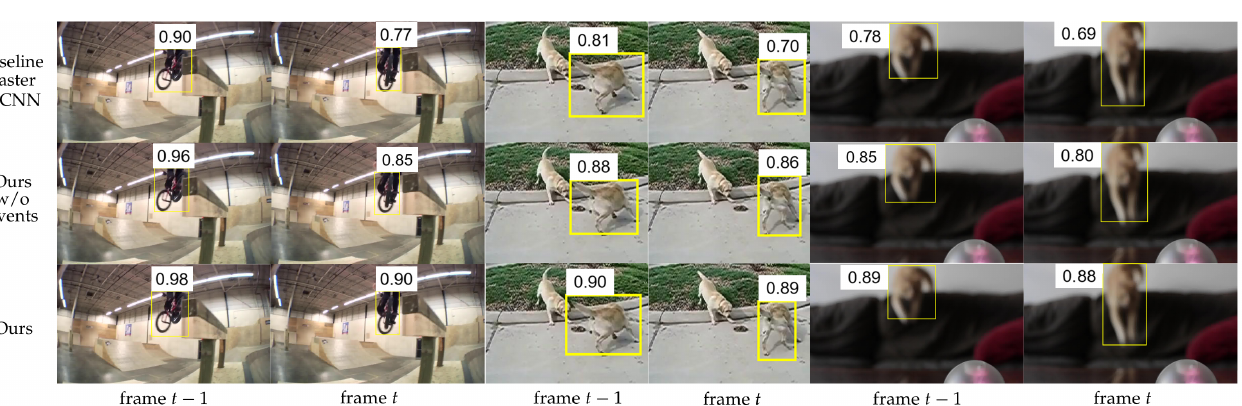
Figure 7. Detection results of “aspect ratio change” events from ImageNet VID validation dataset. Our proposed method using the event detection module shows improvements of detecting “aspect ratio change” events compared with the still-image baseline Faster R-CNN and our proposed method without considering the event detection